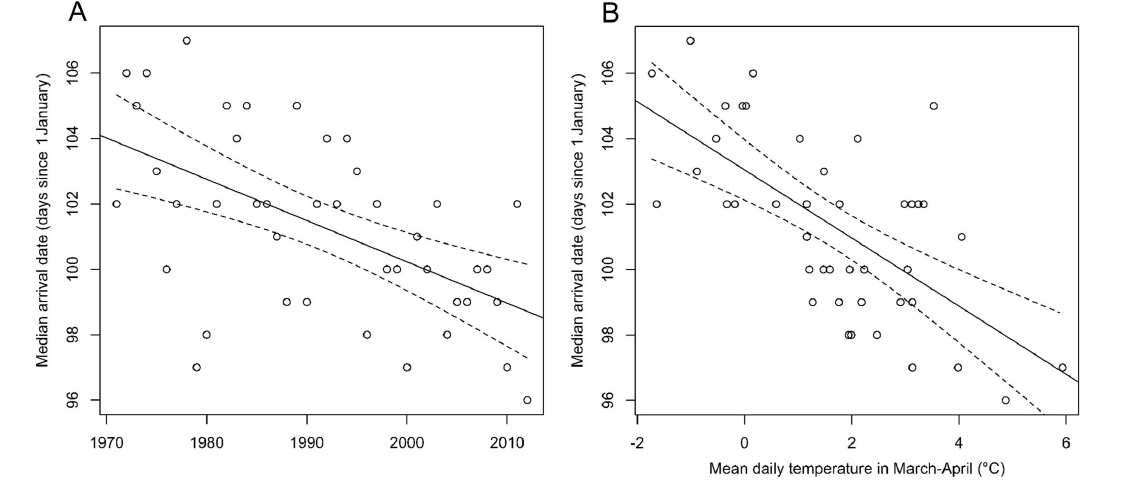
Fig. 1 . Spring median arrival date of Ring-billed Gulls ( Larus delawarensis ) in southern Québec determined from Étude des Populations d’Oiseaux du Québec (EPOQ), 1971-2012, (A) and the relationship with mean daily temperature in March–April (B). The solid line represents the regression function while the dashed lines represent the 95% confidence intervals.